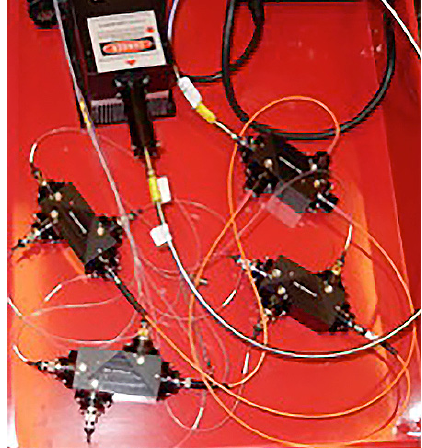
Figure 2. Infrared laser heating system. A main optical fiber for moderate heating connects to a primary three-way splitter box. Three secondary splitter boxes connect via three separate optical fibers to the primary three-way splitter box (orange fibers). Each of the three secondary splitter boxes directs the laser beam through three optical fibers connected to the main optical fiber. Shutter control is performed manually by nine individual shutters.